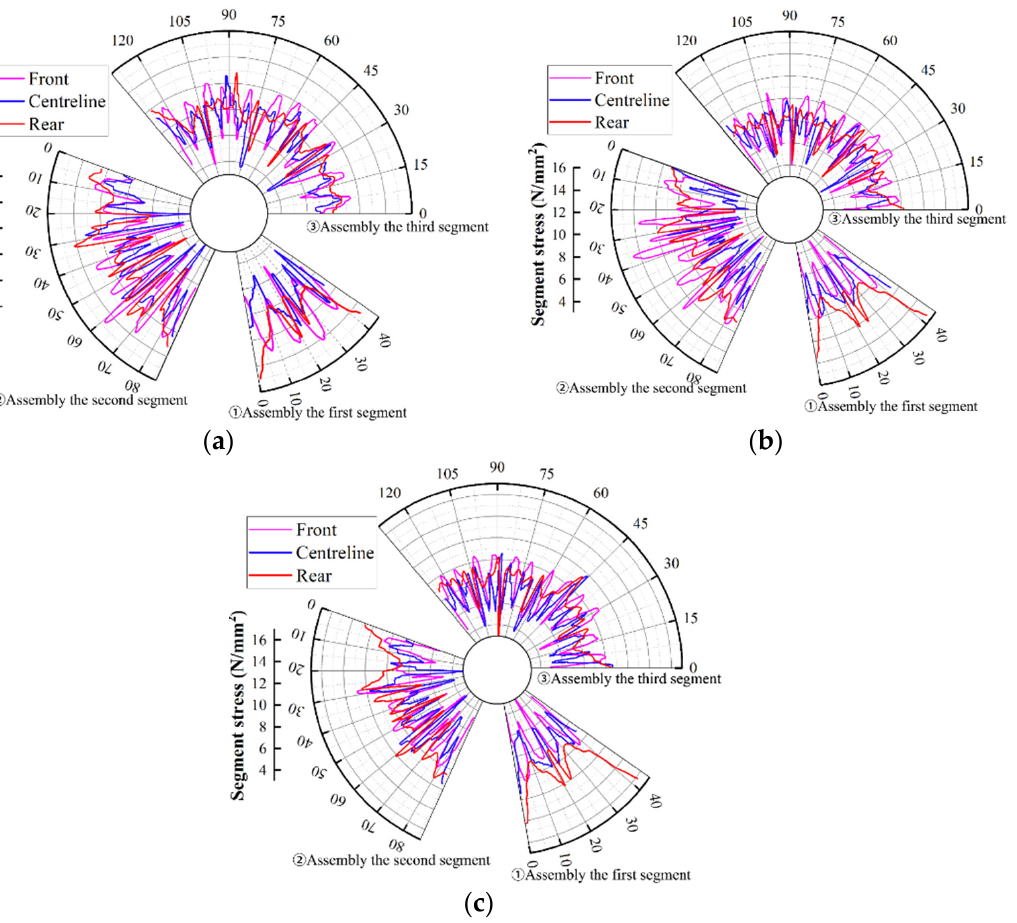
Figure 9. Internal forces in the model: ( a ) the segment at the top; ( b ) the lateral segment; ( c ) the segment at the bottom.